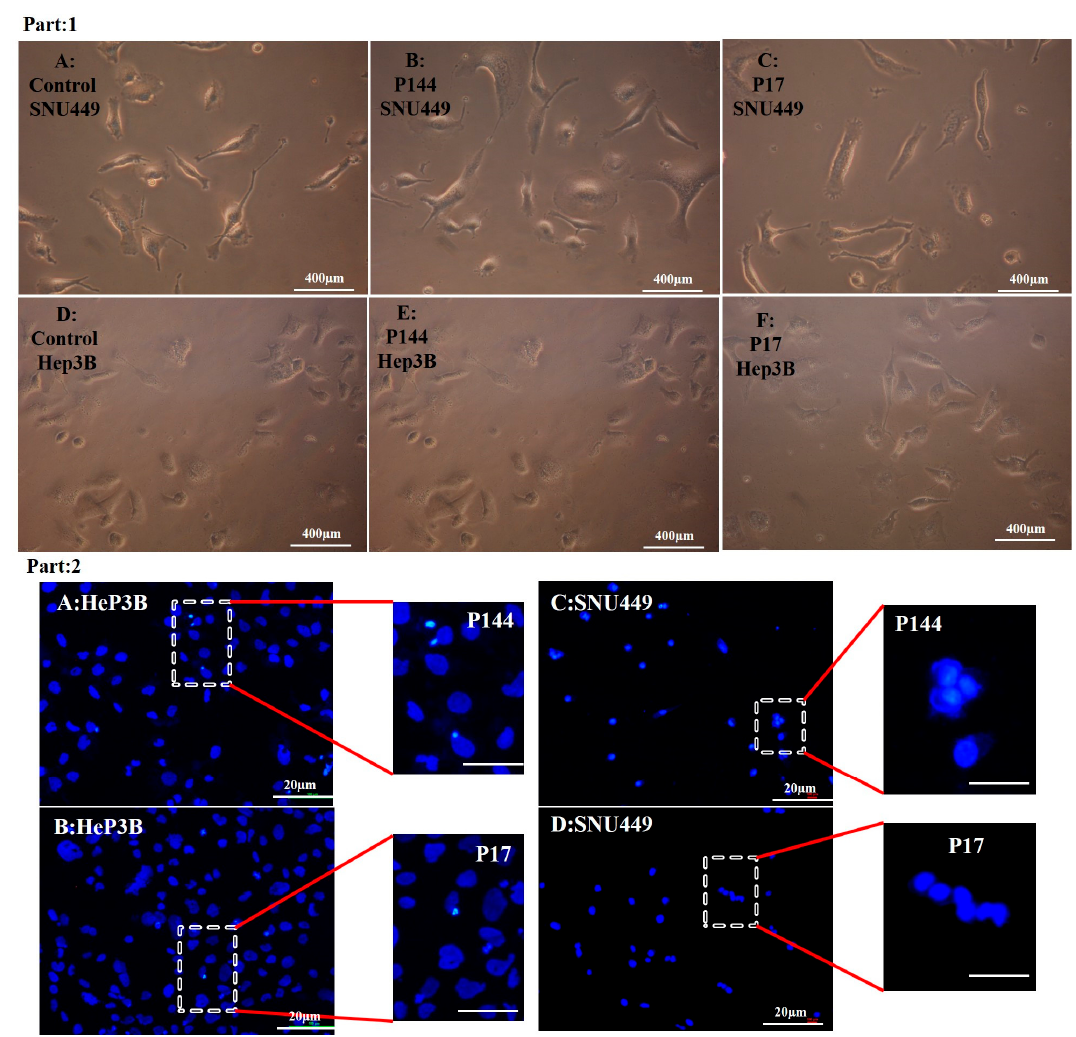
Figure 8. ( Part 1 ) Optical microscopy images SNU449 and Hep3B cell lines suffered from phenotype changes. ( A ) control SNU449. ( B ) SNU449 exposed to 50 µ g / mL P144. ( C ) SNU449 exposed